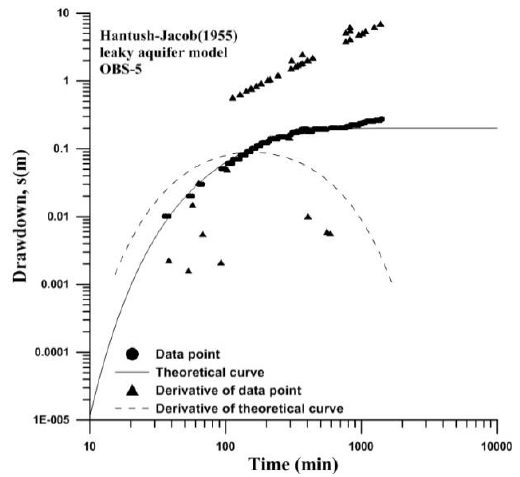
Figure 6. Hantush–Jacob (1955) leaky aquifer model of pumping tests at the OBS-3, MLW-1, MLW-2, MLW-3, and OBS-5 observation wells.